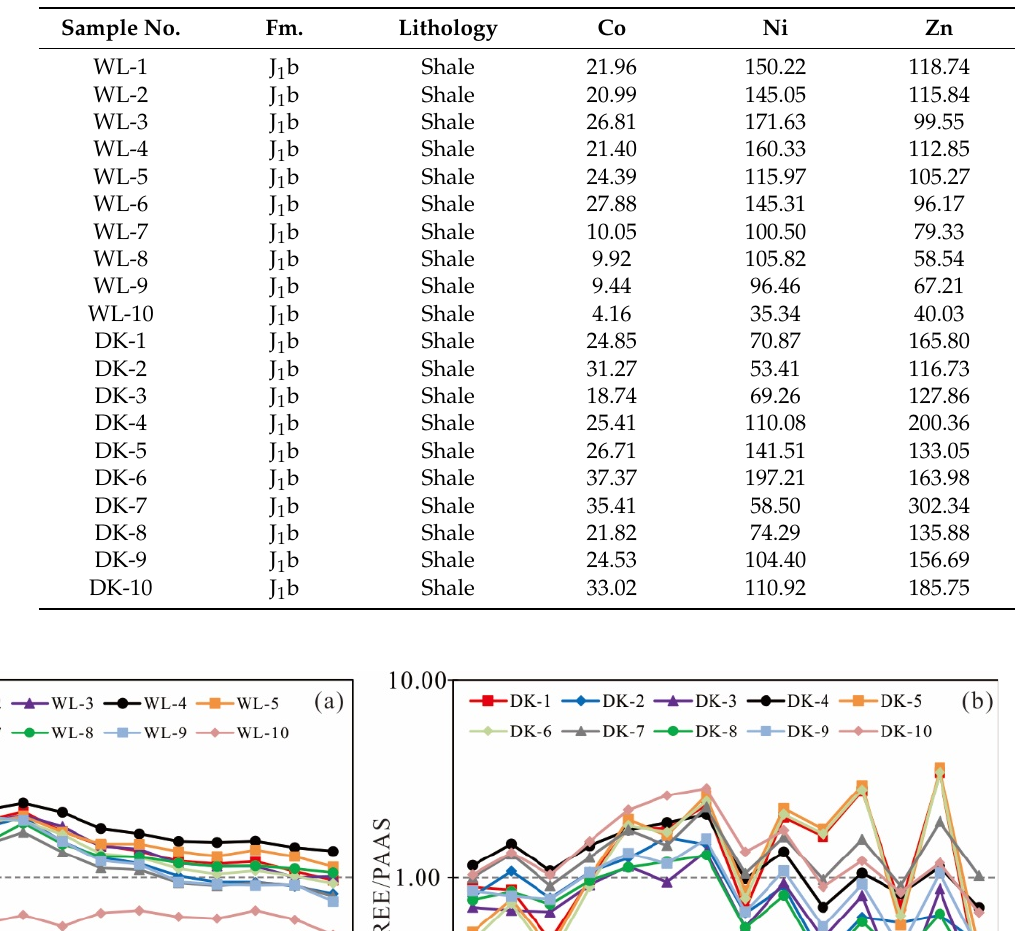
Table 4. Trace elements of the Beipiao samples, in µ g/g. Sample No.